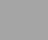
Effects of 19 days of CSC exposure on behavioral, physiological, and immunological parameters. Dominant resident male mice originated from the CD1 strain, CSC mice from the C57BL/6 strain. CSC exposure resulted in increased anxiety-related behavior measured on the elevated plus-maze [EPM; (A)] without affecting locomotor activity (data not shown), decreased thymus weight (B), increased pituitary weight (C), increased adrenal weight (D), reduced adrenal in vitro ACTH sensitivity (E), unaffected basal morning plasma corticosterone [CORT; (F)], a tendency toward increased basal morning plasma adrenocorticotropic hormone [ACTH; (G)], increased histological damage in colonic tissue (H), and increased number of viable mesenteric lymph node cells [mesLNC; (I)].  SHC (n = 7–8); ■ CSC (n = 7–8). Parametric data are represented as mean + SEM. Non-parametric data are represented in box-plot diagrams. Boxes signify the upper and lower quartiles, the median is represented as solid line, and the mean as dashed line within each box. *P < 0.05, **P < 0.01, ***P < 0.001 versus respective SHC; #P < 0.05, ###P < 0.001 versus respective basal values.